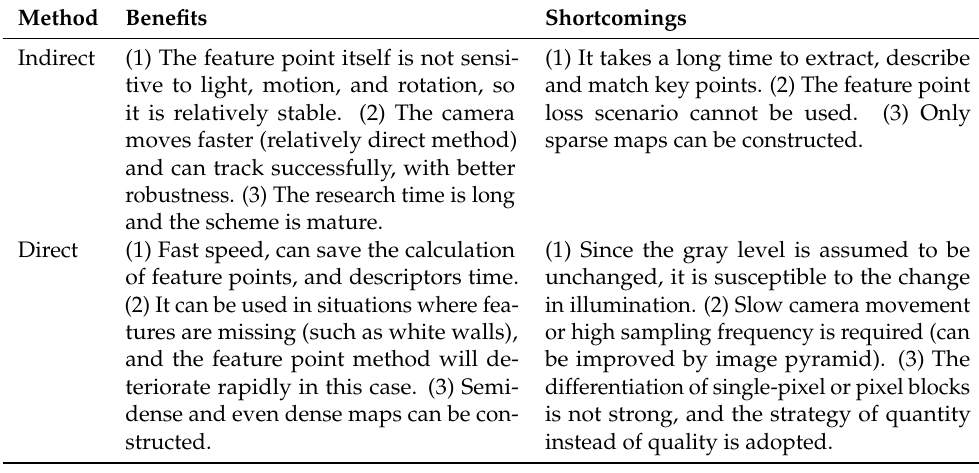
Table 5. Comparison between direct method and indirect